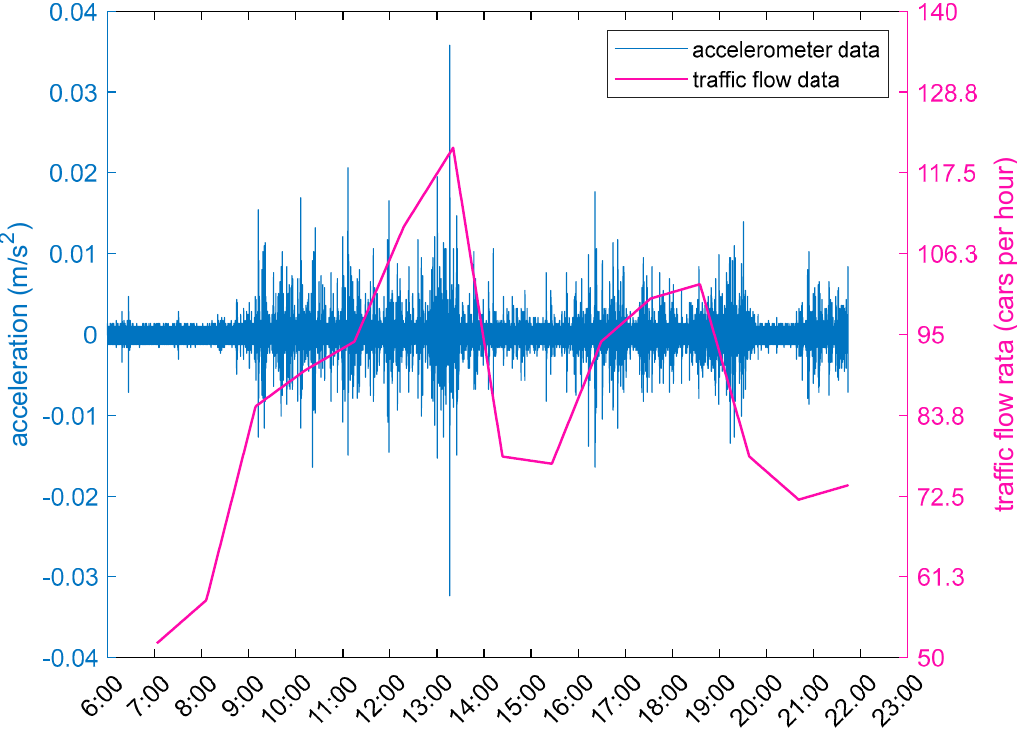
Figure 5. Correlation between acceleration and traffic flow.